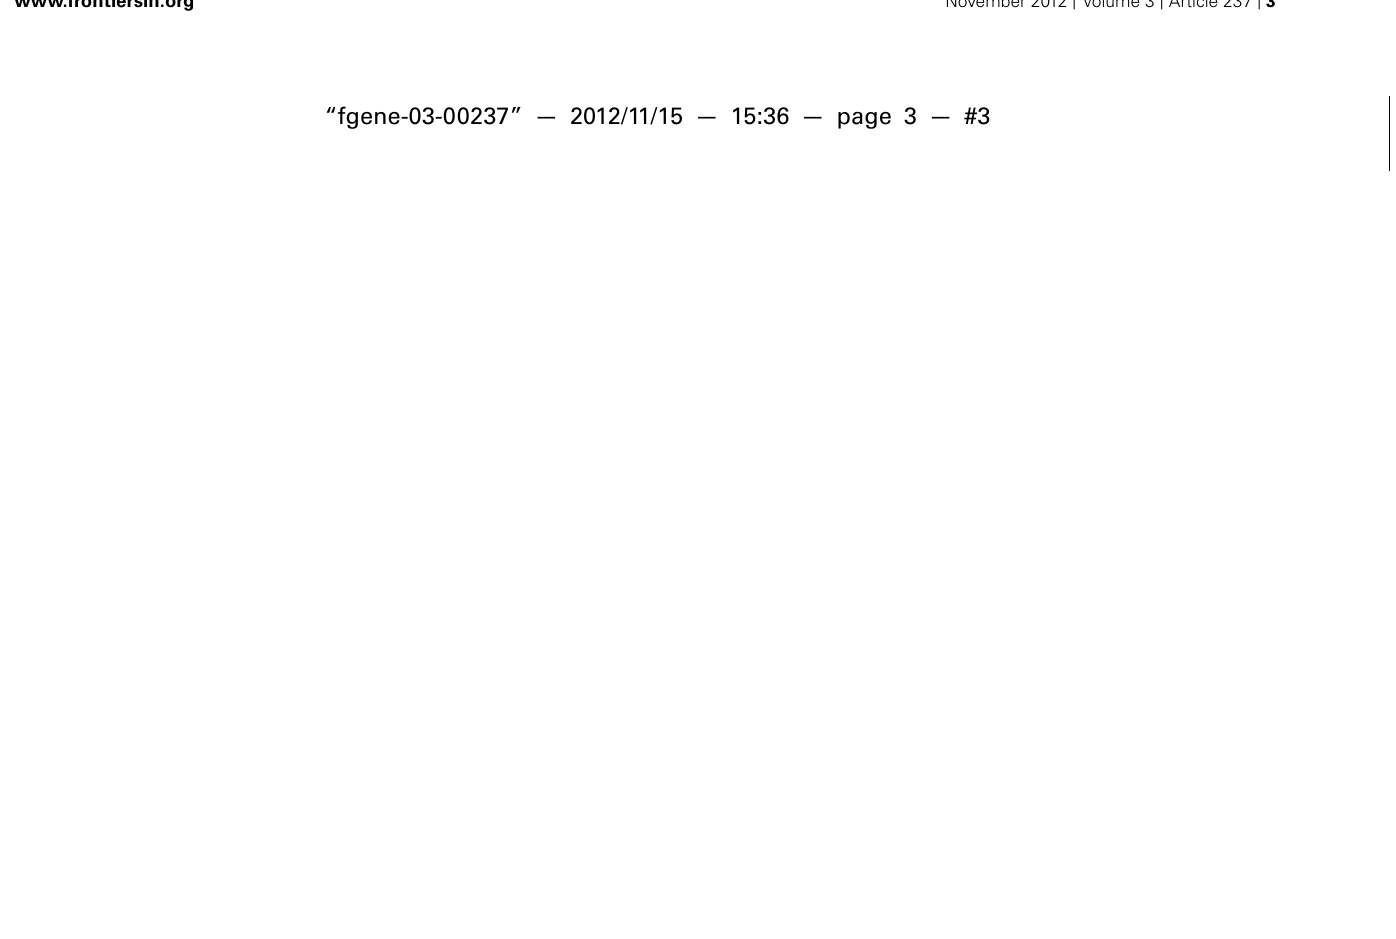
FIGURE 1 | (A) Somatostatin expression decreases with age in control subjects. Individuals with MDD (top panel) and schizophrenia (bottom panel) display lower levels of expression than control subjects at most ages, together prompting the hypothesis that decreased expression of somatostatin in depression and schizophrenia may represent early brain age-related molecular phenotypes in these individuals, which would render these subjects more vulnerable to developing psychiatric diseases. (B) Based on similar age and disease observations for numerous additional genes, we have proposed a model of “age-by-disease biological interaction” (Glorioso etal., 2011). In this model, change in expression of disease-related genes (a